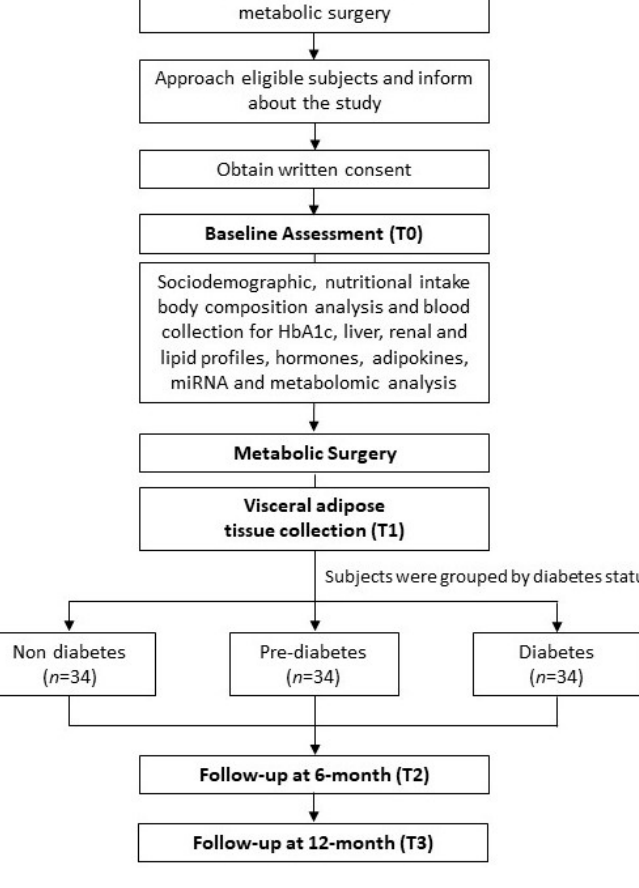
Figure 2. Proposed research workflow.